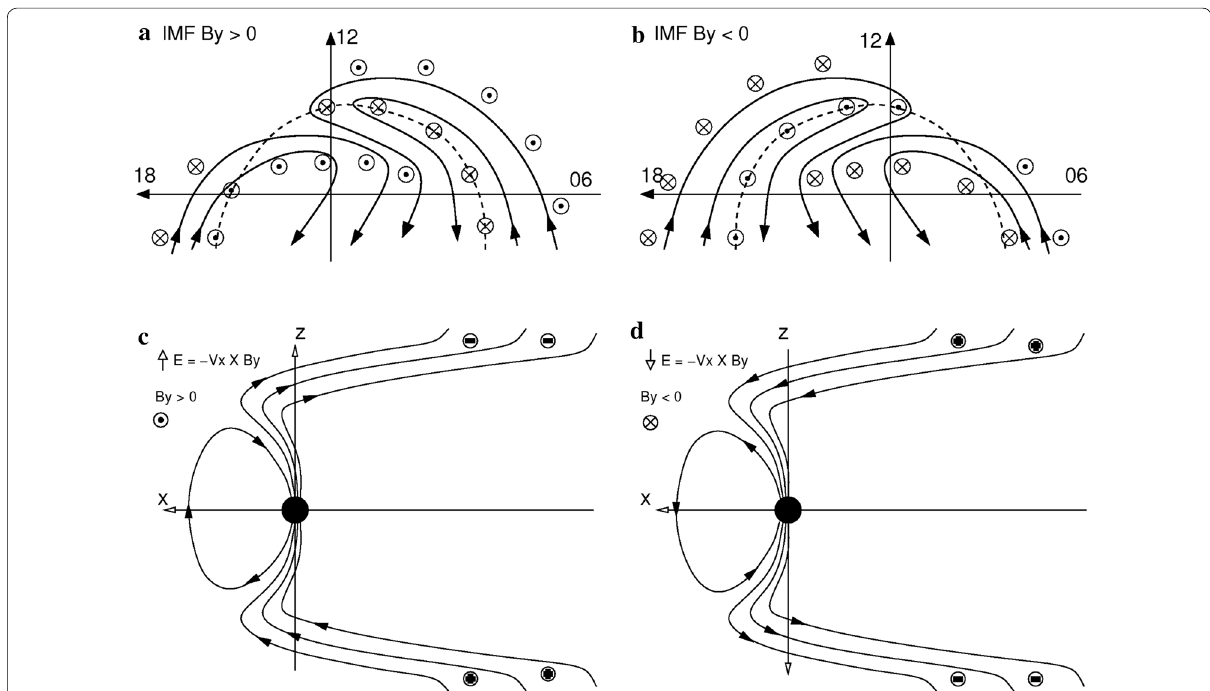
Fig. 6 Schematic drawing of the ionospheric plasma flows associated with a interplanetary magnetic field (IMF) B y > 0 and b IMF B y < 0 (based on Cowley et al. (1991)). The dashed line in each panel delineates the open-closed magnetic flux boundary and the circled symbols represent the field-aligned current flows (upward for circles with a dot and downward for circles with a cross). The bottom row shows the field-aligned current system associated with c IMF B y > 0 and d IMF B y < 0 (based on Trondsen et al. 1999). The IMF B y field produces a north–south potential drop across the magnetotail that drives field-aligned currents northward or southward depending on the orientation of IMF B